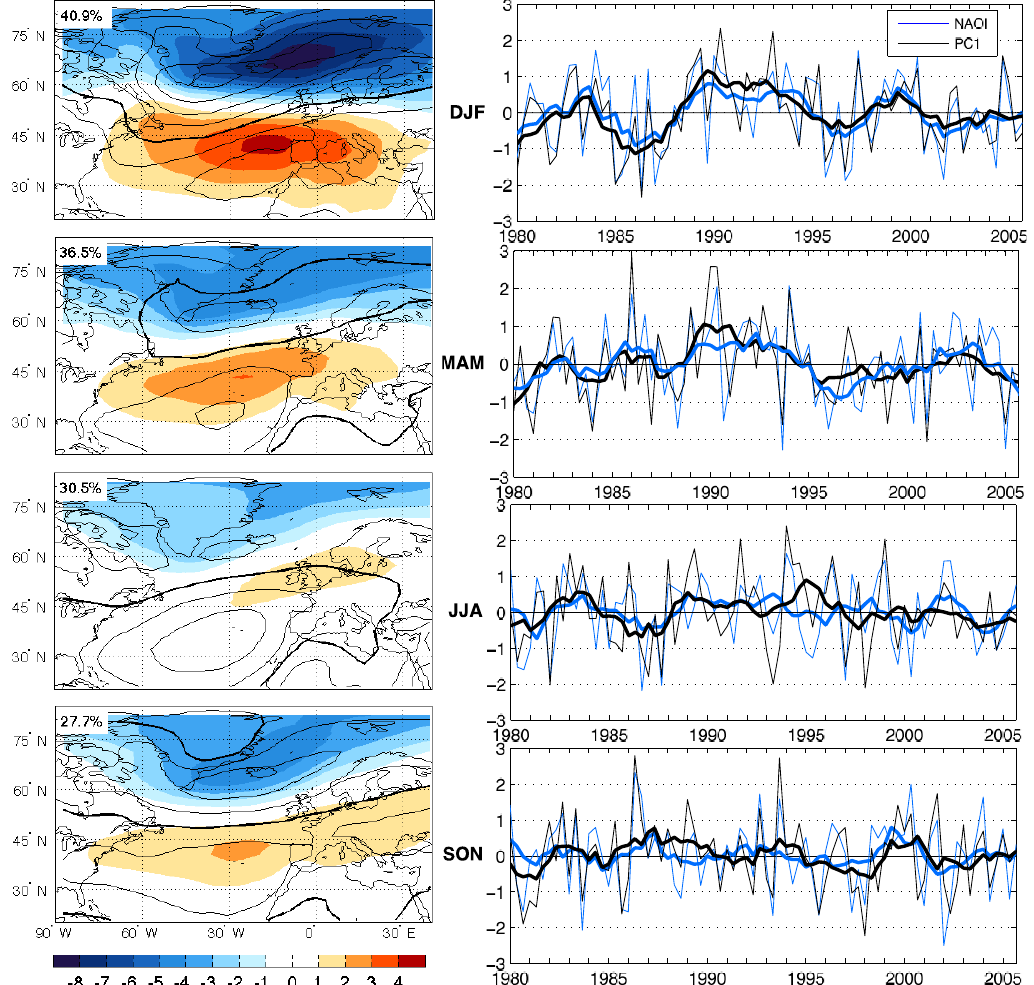
Fig. 1. Left panels: Simulated leading EOF of monthly SLP anomalies (colored shading:hPa/standard deviation of PC) using data from all months of each season and SLP mean (contours: 4hPa interval from 998 to 1022hPa; bold contour denotes 1014hPa) in the North Atlantic sector. The EOF patterns represent the SLP anomalies associated with normalized PC1 equal to 1 for the NAO positive phase (opposite sign for the NAO negative phase). Bold numbers in the upper left corners show the amount of variance explained by the first EOF as a percentage of the total variance for each season. Right panels: NAOI (blue) and normalized PC1 (black) timeseries for each season. The bold lines show the 6-month (2 seasons) running